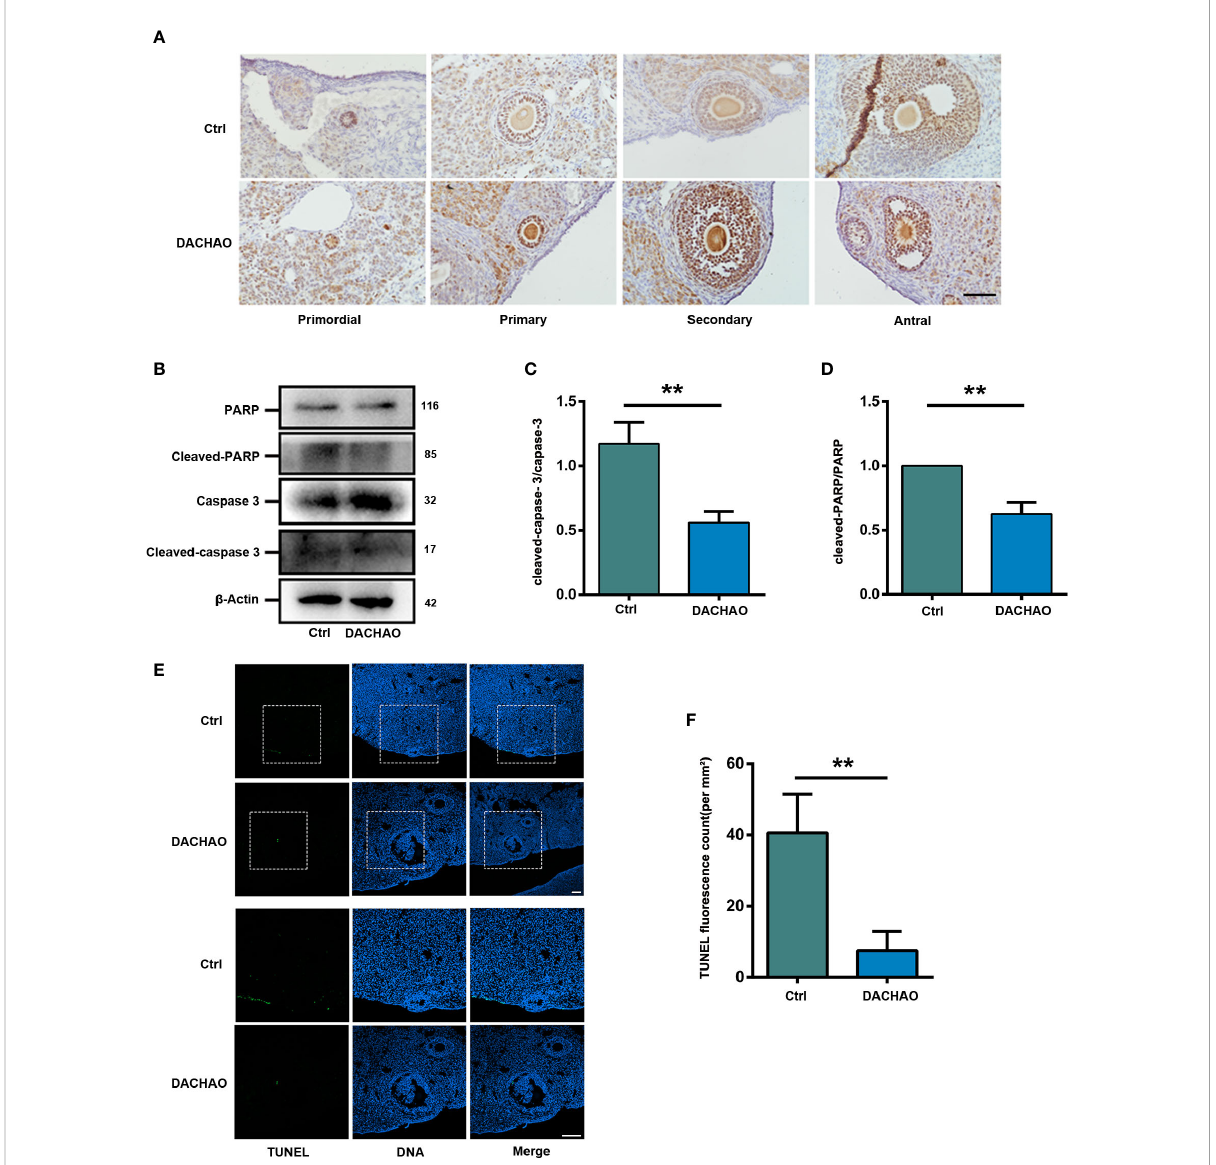
FIGURE 5 DACHAO improves fertility by promoting granulosa cell proliferation and reducing apoptosis in ovaries. (A) The morphology of PCNA immunohistochemical staining in different follicular development stages of mouse ovary in each group. (B) Western-blots of the expression of apoptosis-related proteins in mice ovaries in each group. (C, D) Gray value analysis of Western blots in (B) was quanti fi ed and is shown by cleaved-caspase-3-to-caspase-3 ratios, cleaved-PARP-to-PARP ratios (n=3/group). (E) TUNEL staining of ovaries of aged female mice in each group. (F) Statistical graph of the number of TUNEL staining positive signal points in the ovaries of aged female mice in each group (n=3/group). Data are presented as means ± SEM of three independent replicates. **P < 0.01, compared with the control group. n = the number of mice in each group. All bars = 50 m